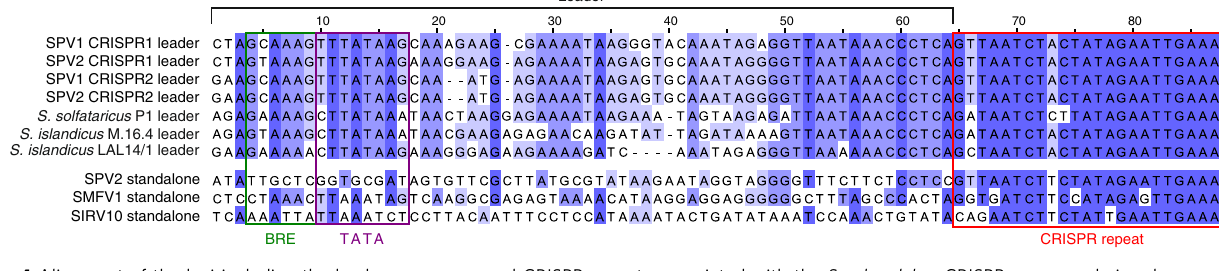
Fig. 4 Alignment of the loci including the leader sequences and CRISPR repeats associated with the Saccharolobus CRISPR arrays and virus-borne mini- CRISPR arrays. The bottom 3 sequences correspond to stand-alone CRISPR repeats. BRE and TATA elements found in the promoters of the leader sequences are